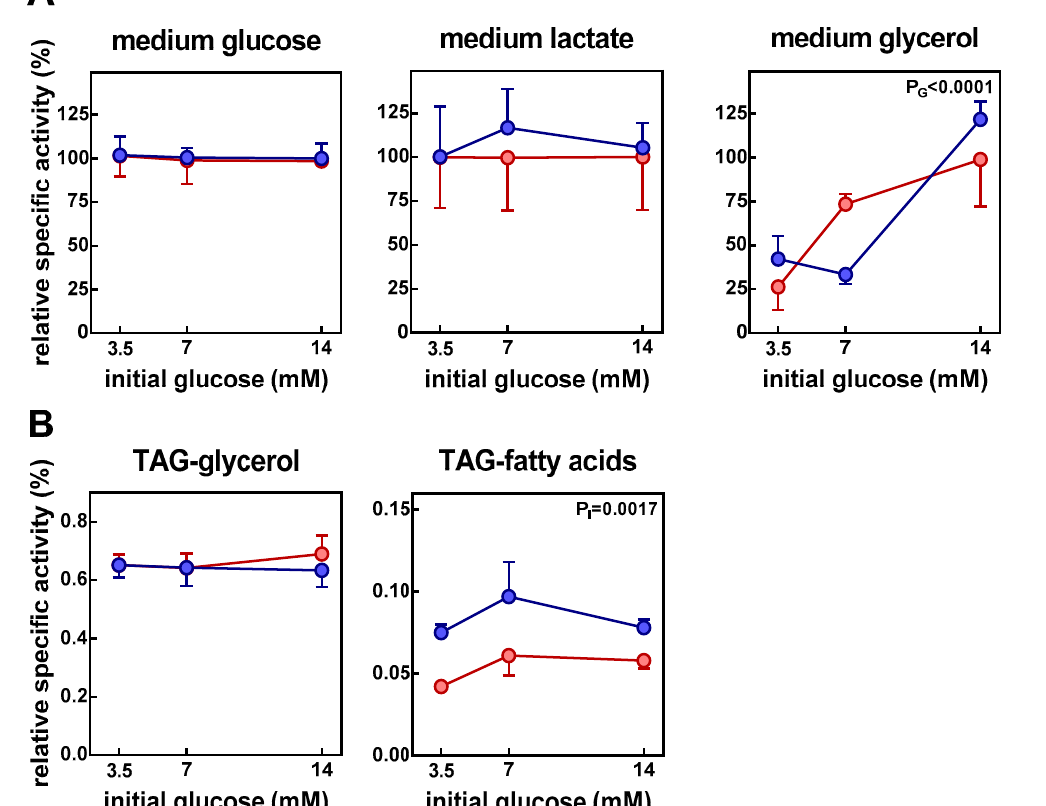
Figure 2. Insulin effect in the carbon specific radioactivity of the main label fractions obtained from 14 C-glucose after incubation of epididymal adipocytes in a primary culture. The data are presented as mean ± SEM from six different animals. Specific radioactivities ( A ) from label fractions (glucose, lactate, and glycerol) in the medium and ( B ) from label fractions (glycerol and fatty acids) in cell triacylglycerol (TAG). C-specific radioactivity corresponds to the quotient of label found in the fraction divided by the molar concentration and the number of carbons the compound contains. In this case, all data have been referred to initial glucose C-specific radioactivity, to which a value of 100 was given. Red circles: adipocytes incubated in absence of insulin; blue circles: adipocytes incubated in presence of insulin. The statistical significance data and conventions are the same as in Figure 1.